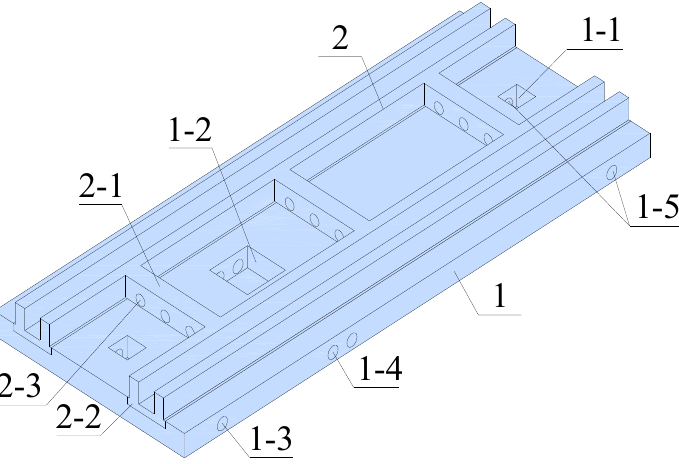
Figure 3. Schematic diagram of NFET structure.